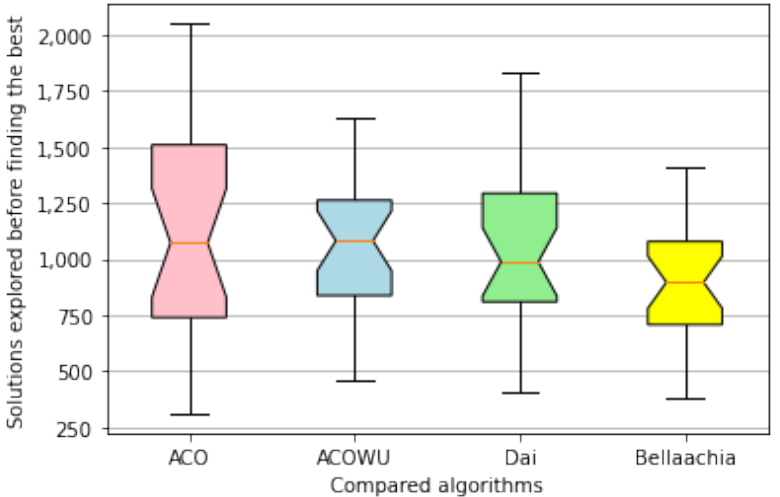
Figure 2. Comparison of iterations on generic TSP